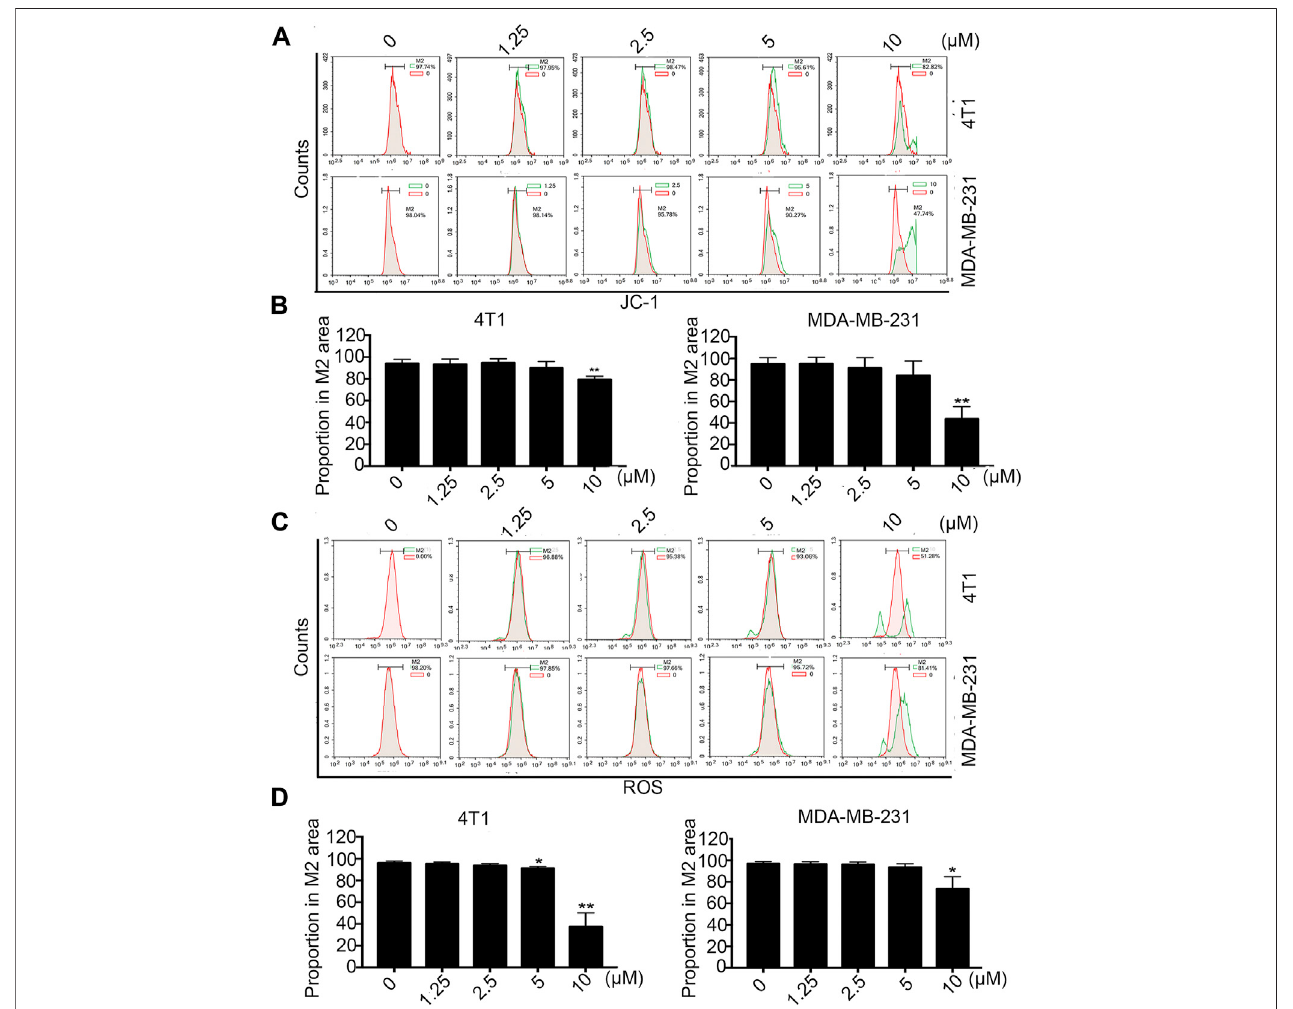
FIGURE 5 | The effect of Statmp-151 on mitochondrial ΔΨ m and ROS. (A) Statmp-151 decreased the mitochondrial membrane potential in 4T1 and MDA-MB- 231 cells. (B) The mitochondrial ΔΨ m results were presented using quanti fi ed. (C) The levels of ROS were decreased after treatment with Statmp-151. The harvested 4T1 and MDA-MB-231 cells were measured by FCM. (D) The ROS data is presented in a histogram. Data are present as mean ± SD for at least three independent experiments (* p < 0.05, ** p < 0.01 and *** p < 0.001 vs. control